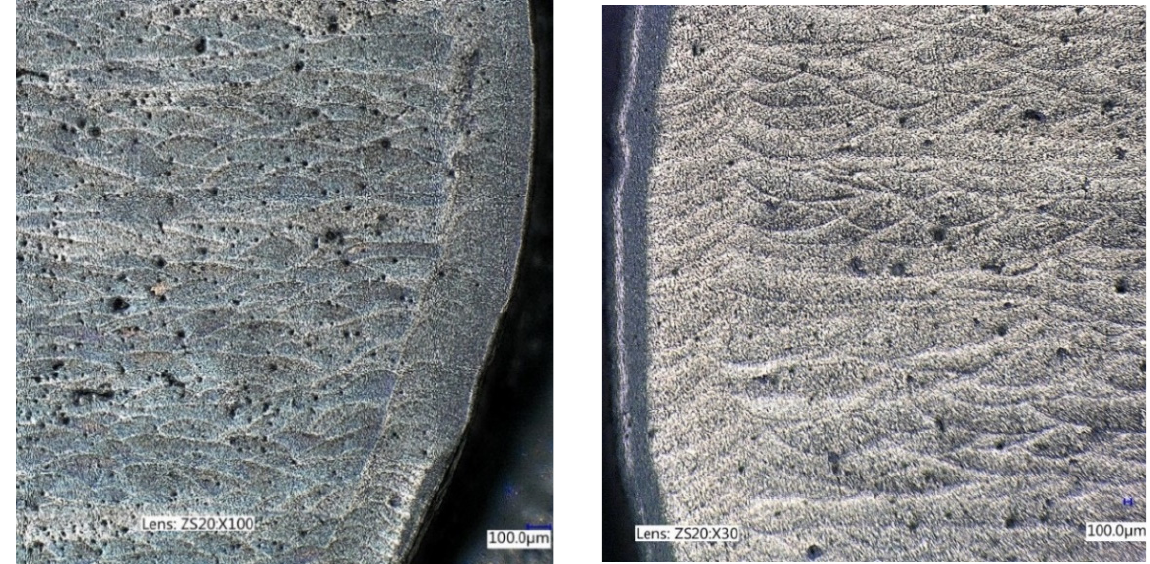
Figure 6. Defects in the specimen cross-section: AM vertical ( left ) and AM horizontal ( right ) [28].